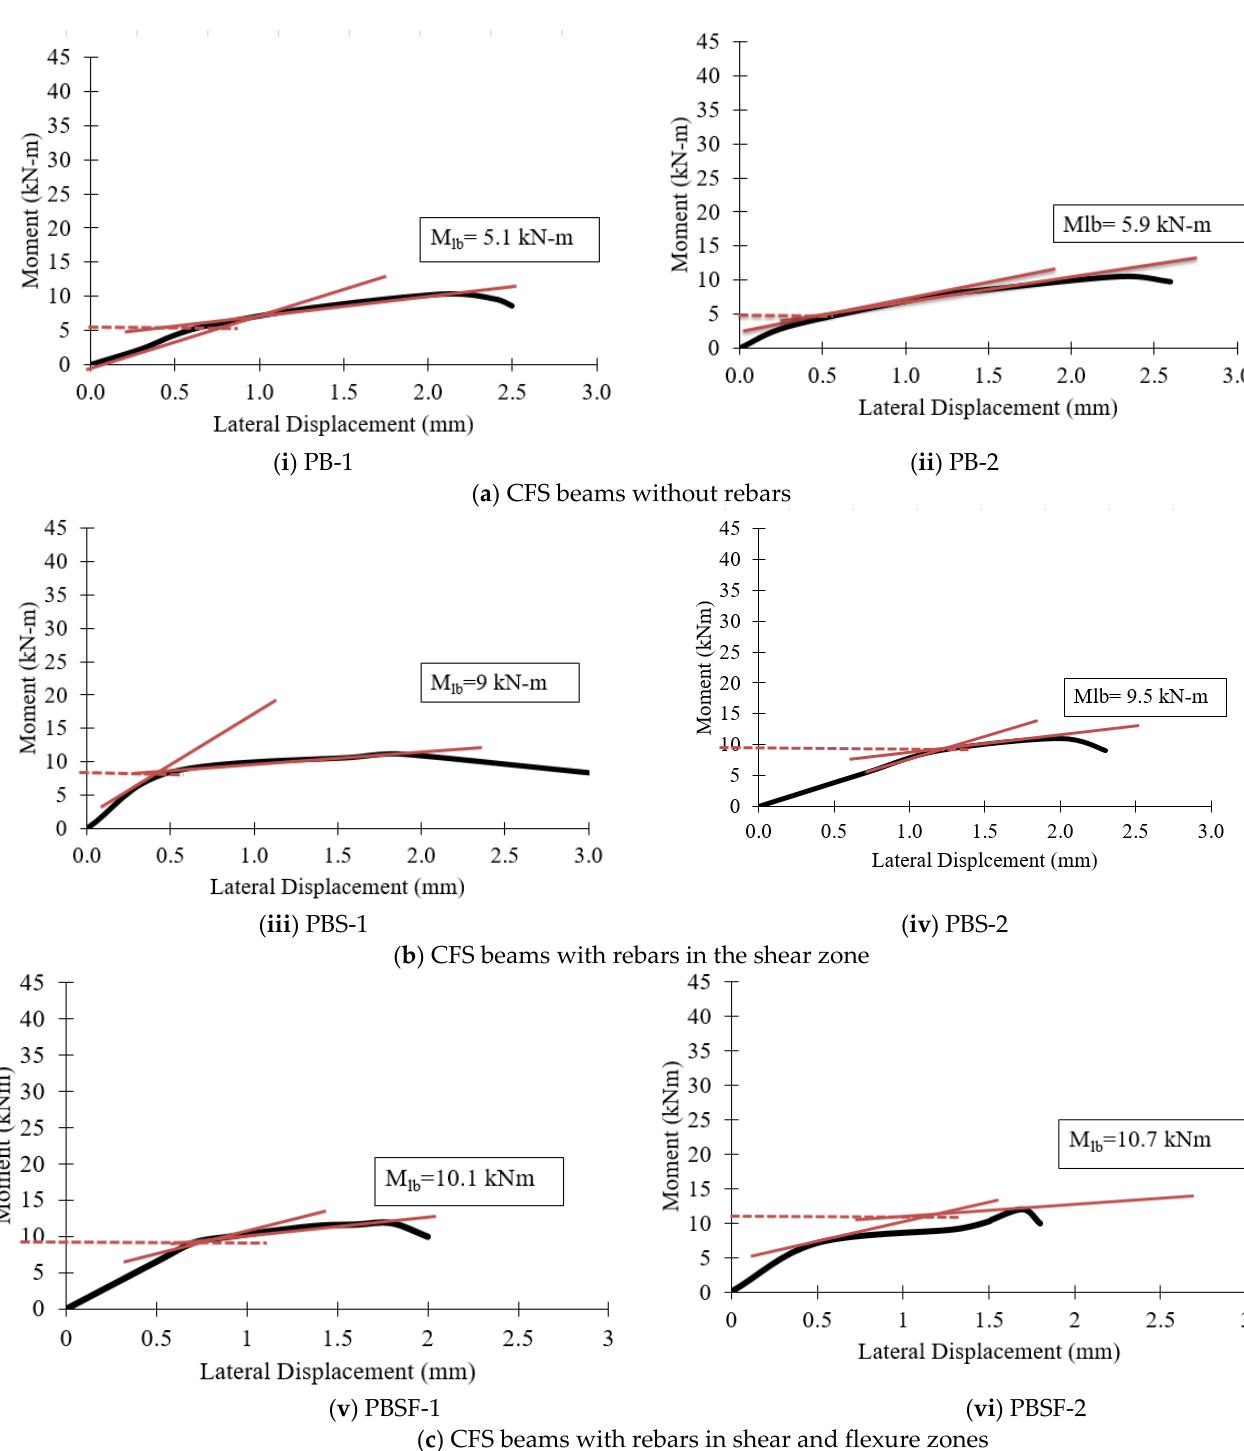
Figure 14. Moment–lateral displacement curves of the plain CFS